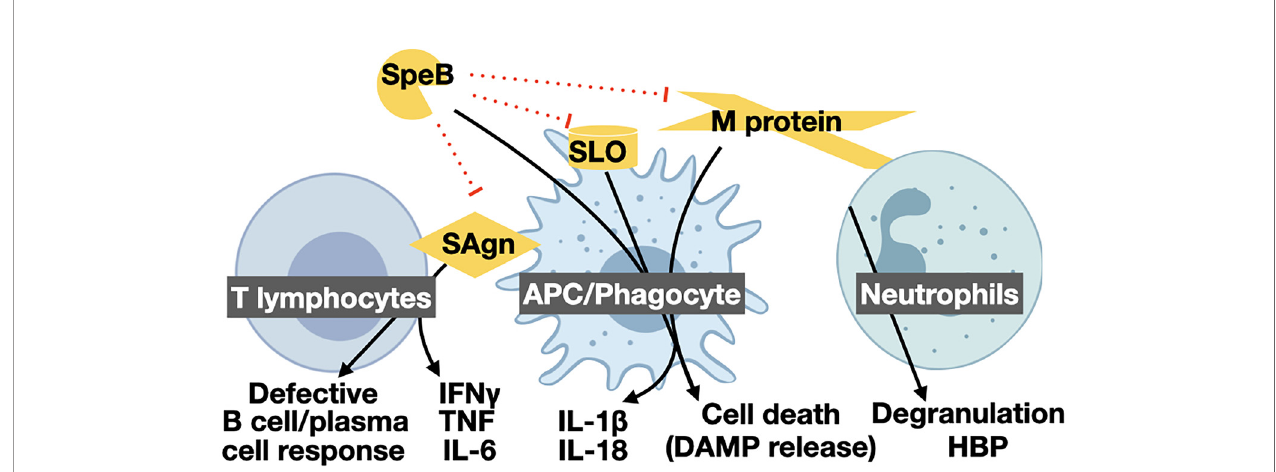
FIGURE 1 | Proin fl ammatory virulence mechanisms of GAS and their targets. The GAS protease SpeB is directly proin fl ammatory by activating pro-IL-1 b , other host substrates, and inactivating anti-in fl ammatory GAS effectors. SpeB cleavage of other proin fl ammatory cytokines, and proin fl ammatory virulence factors such as superantigens (SAgn), streptolysin O (SLO), and M protein can lead to their inactivation and have anti-in fl ammatory contributions. Superantigens forcibly bind T lymphocytes and APCs, leading to excessive T cell activation. Activated T cells kill other immune cells and release a “ cytokine storm ” of IFN- g , TNF, and IL-6, hallmark of STSS. The pore-forming toxins SLO and streptolysin S (SLS) form large pores in host cells that can lead to the passive release DAMPs, and other cytosolic or organelle-associated proin fl ammatory compounds, or be detected by the in fl ammasome to further activate in fl ammatory cell death by pyroptosis. Proin fl ammatory effects of SLO can include aiding translocation of the virulence factors Nga. M protein proteolytically released from the GAS surface can similarly form complexes that induce pyroptosis in macrophages or hyper-degranulation by neutrophils. Like other microbes, GAS has numerous TLR agonists that activate proin fl ammatory regulatory programs [reviewed in (LaRock and Nizet, 2015)]. Created with